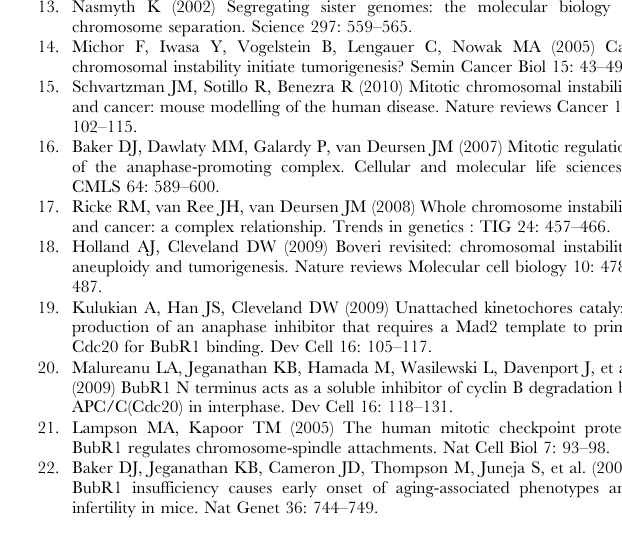
Figure S2 Potential models for selective reprogramming of aneuploid BubR1 H/H MEFs. We observed that . 90% BubR1 H/H iPSC clones have a majority population consisting of a chromosome number other than 40 even though only 38% of MEFs were aneuploid at the onset of reprogramming. Two possible mechanisms, designated A and B, might explain this observation. According to mechanism A (highlighted in black